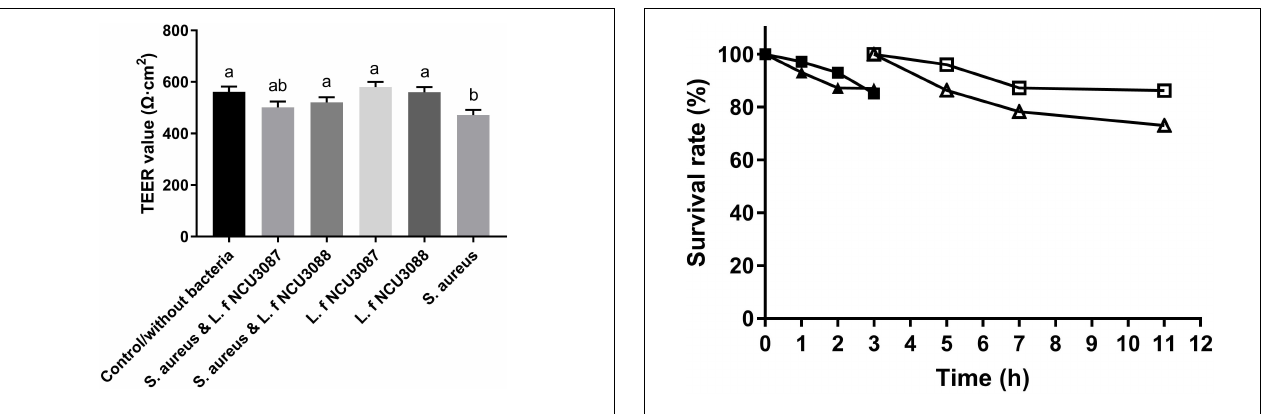
sensitive to clinically relevant antibiotics such as cefotaxime, penicillin, tetracycline and ampicillin. To the other six tested antibiotics, both strains showed resistance.